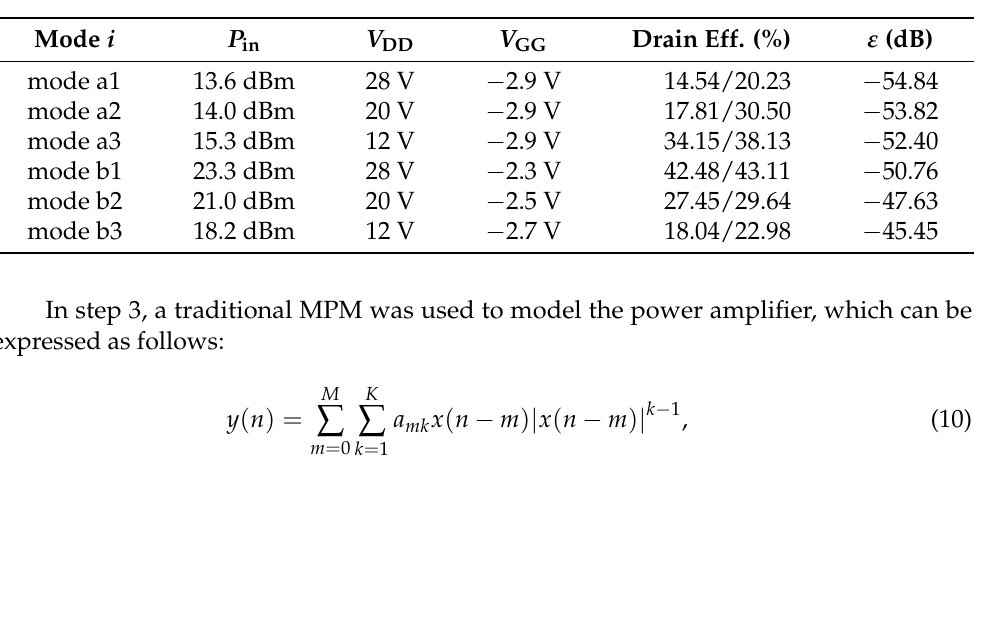
Table 2. Different modes setup of Group A (mode a1, mode a2, and mode a3) and Group B (mode b1, mode b2, and mode b3). Format of the drain efficiency (eff.) column: without CMUDPD and with